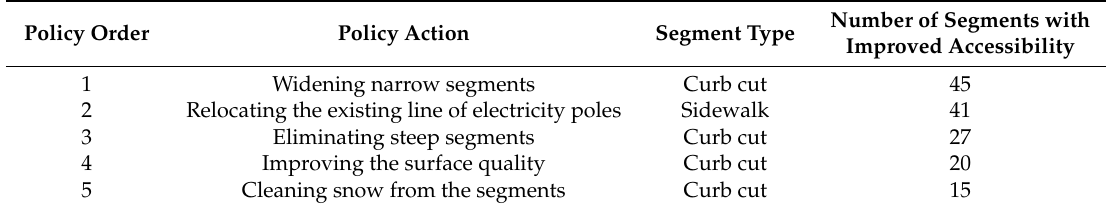
Table 7. Order of the different policy